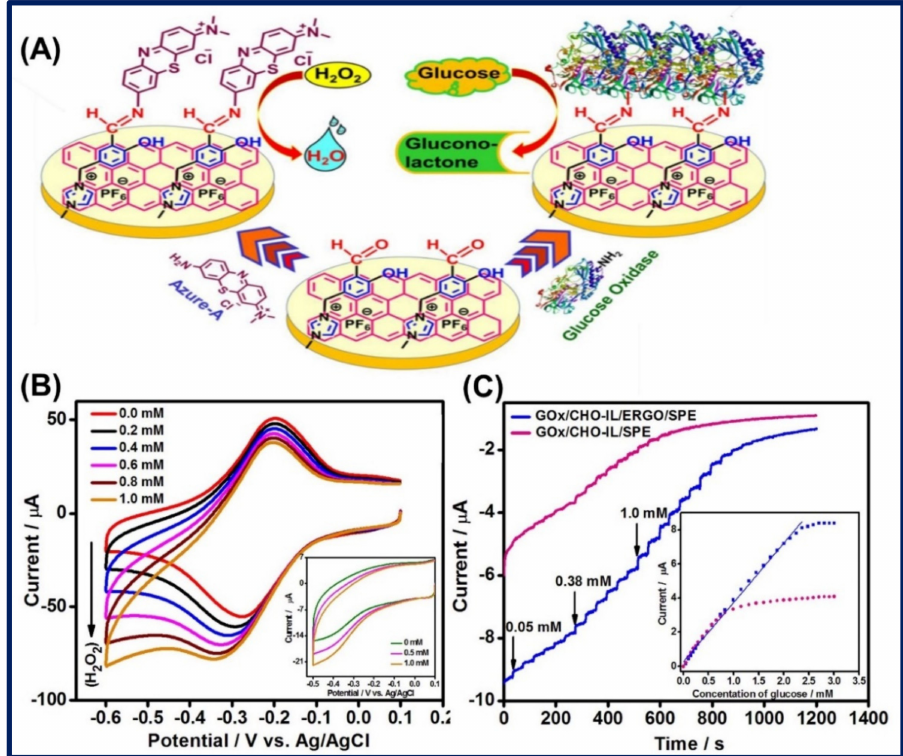
Figure 14. ( A ) Schematic illustration of the electrochemical sensor platform for H 2 O 2 and glucose detection. ( B ) CVs plot of Azu-A/CHO-IL/ERGO/SPE with increasing concentration of H 2 O 2 . ( C ) Amperometric response for Azu-A/CHO-IL/SPE and Azu-A/CHO-IL/ERGO/SPE on successive additions of 30 µ M H 2 O 2 into the electrolyte. Reprinted with permission from Ref. [136]. Copyright 2018,